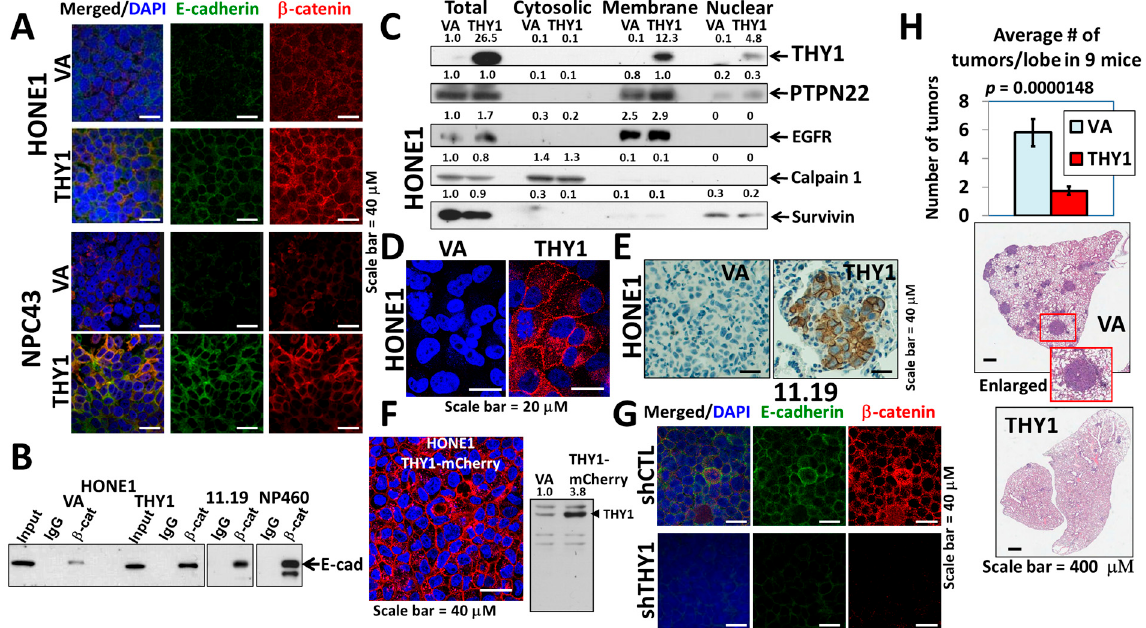
Figure 1. THY1 is involved in maintaining adherens junctions in NPC. ( A ) IF staining of β -catenin and E-cadherin in the HONE1 and NPC43 THY1 transductants. VA, vector-alone. ( B ) Formation of the E-cadherin- β -catenin complex in the THY1-expressing cells. Input stands for total lysate without antibody pulldown. ( C ) Expression of proteins of interest in the cytosol, membrane, and nuclear fractions of THY1 transductants. ( D ) IF staining of THY1 (red) in transplanted THY1 transductants. ( E ) IHC staining of THY1 in transplanted THY1 transductants (small tumor). ( F ) The fluorescent signal of the THY1-mCherry fusion protein in HONE1. Western blot analysis of THY1-mCherry in HONE1 was also shown. ( G ) IF staining of β -catenin and E-cadherin in the THY1 shRNA (shTHY1) knockdown clone of HK11.19. shCTL, control shRNA. ( H ) The results of the lung metastasis assay of the THY1 transductants. Representative H&E staining of a single lobe of a lung from the THY1 and VA transductants.